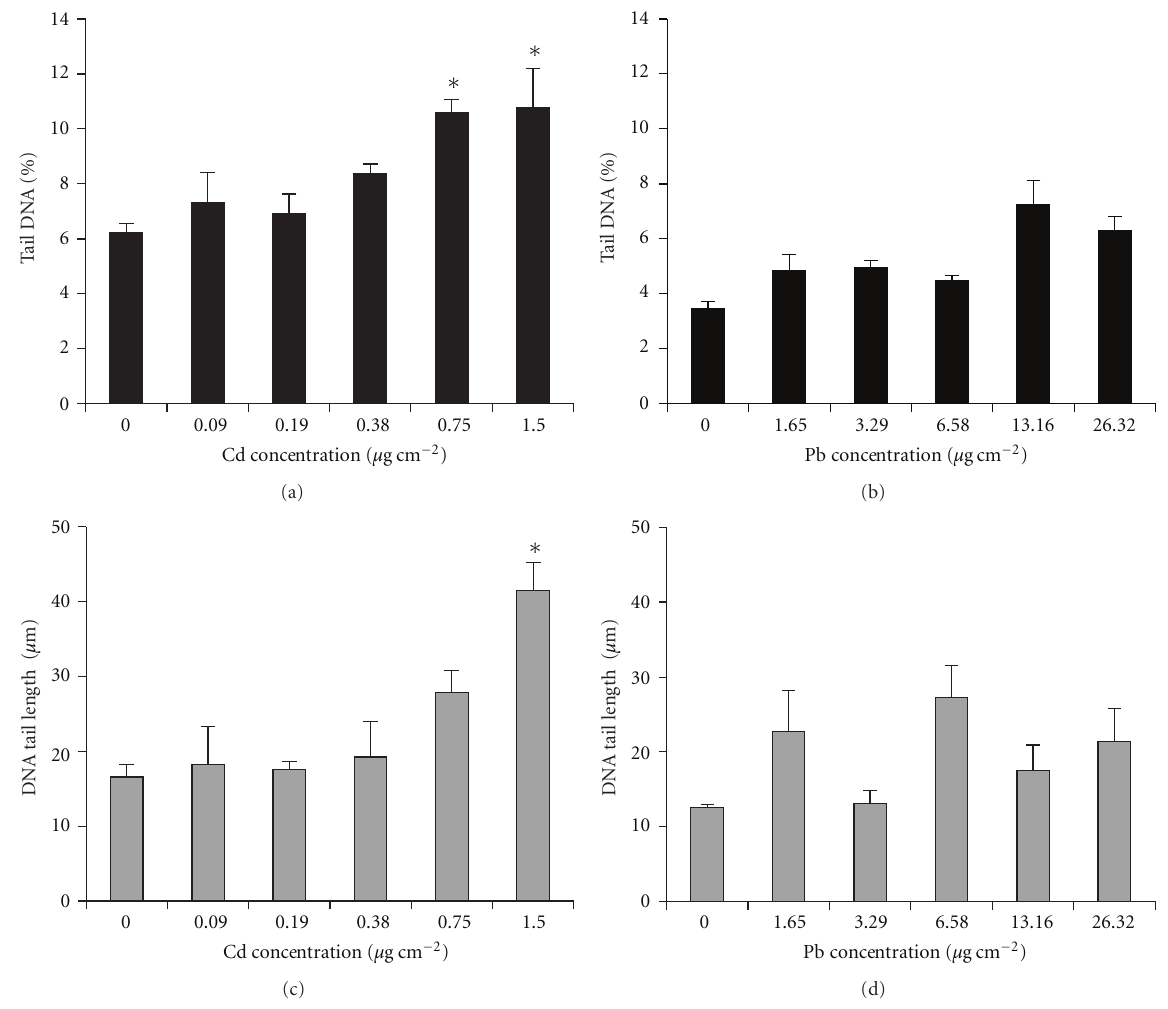
Figure 3: Tail DNA% (a and b) and DNA tail length (c and d) (mean ± SE) of Pheretima peguana coelomocytes exposed to Cd (a and c) and Pb (b and d), respectively, in filter paper for 48-h. ∗ Significantly di ff erent from the control ( P < .